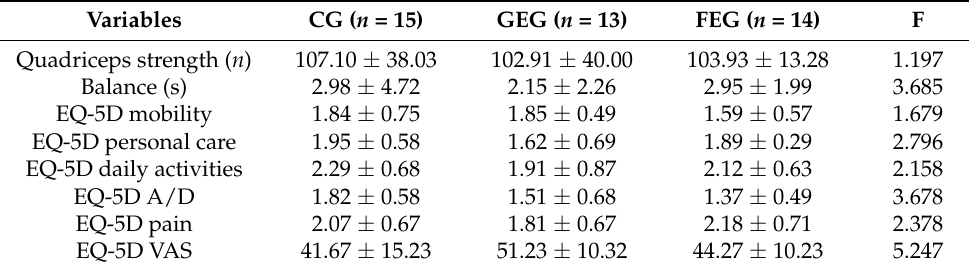
Table 2. Main outcomes at admission in each group.